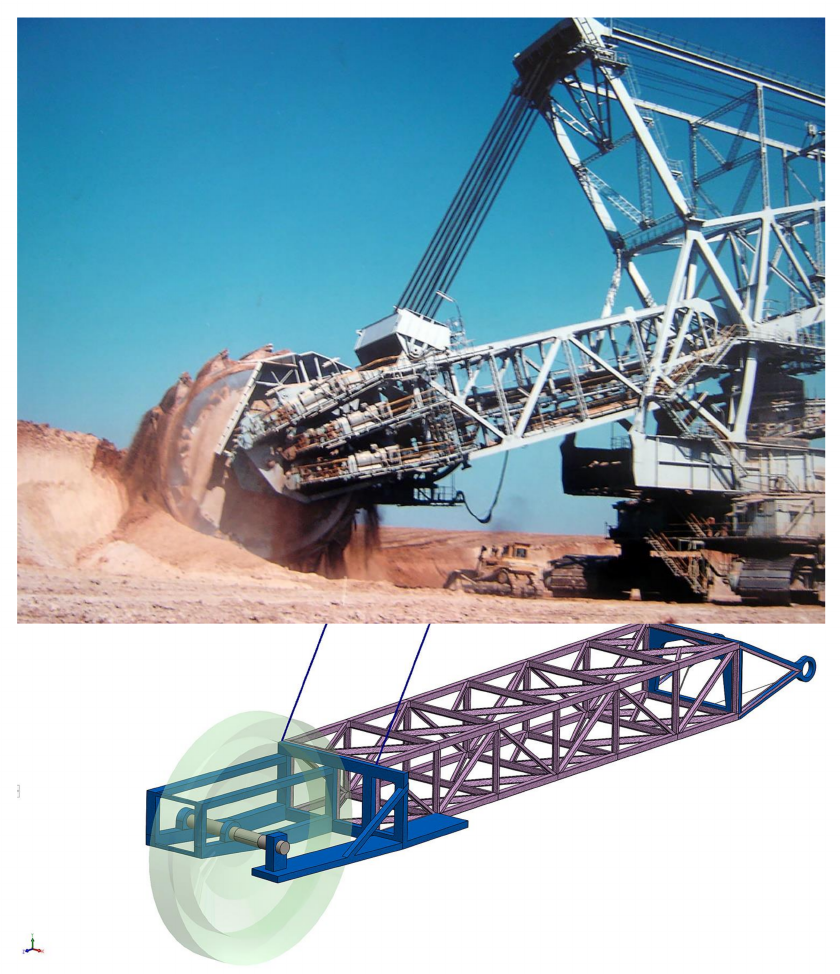
Figure 2. The boom of the excavator: top—real machine; bottom—developed model.